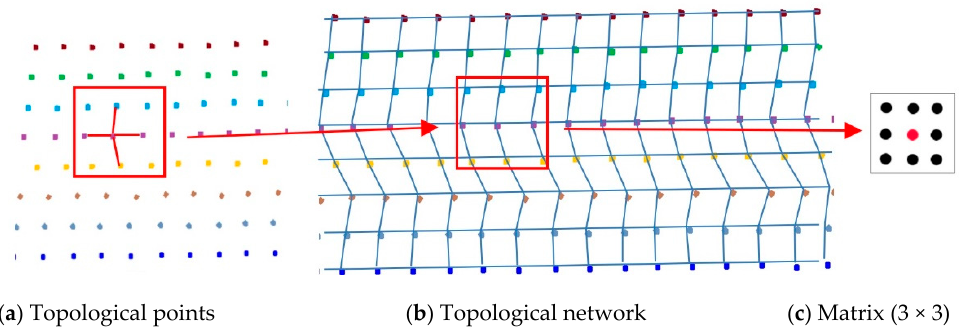
Figure 2. Construction of the topological network; different colors represent different scan lines.